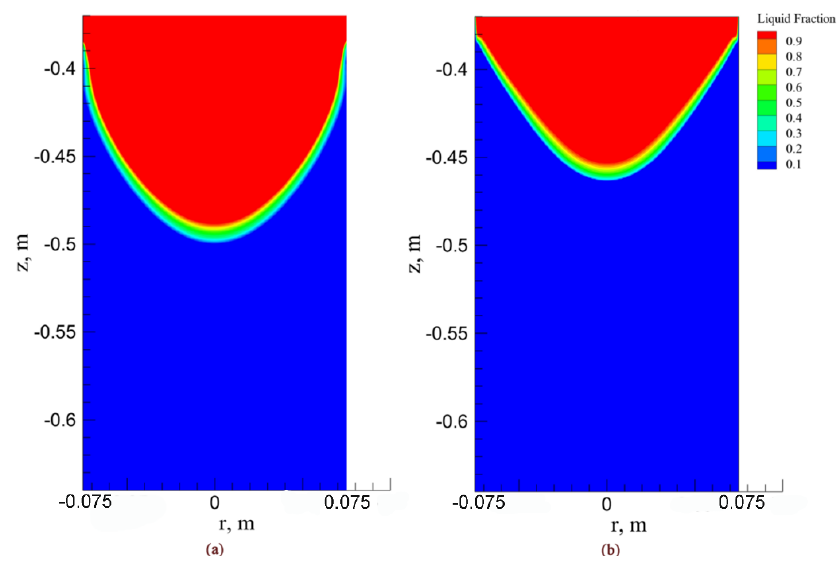
Figure 19. Profile of molten metal pool with droplet effect. ( a ) OE-ESR. ( b ) TSCE-ESR.